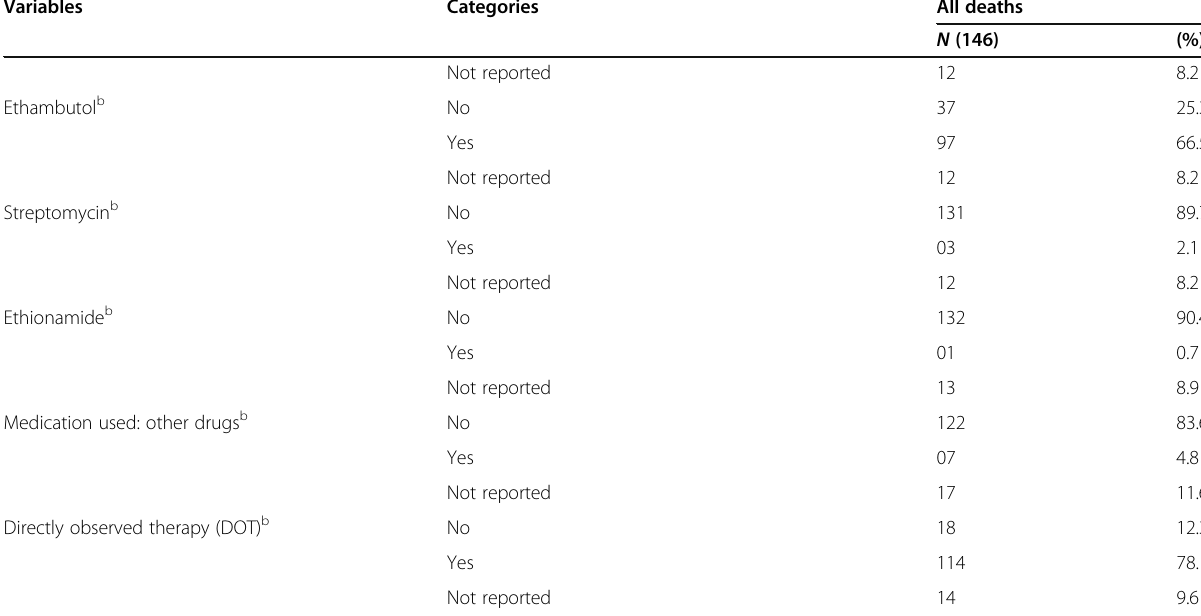
Table 2 Characteristics of the patients who died due to TB, Curitiba-Brazil (Continued) Variables